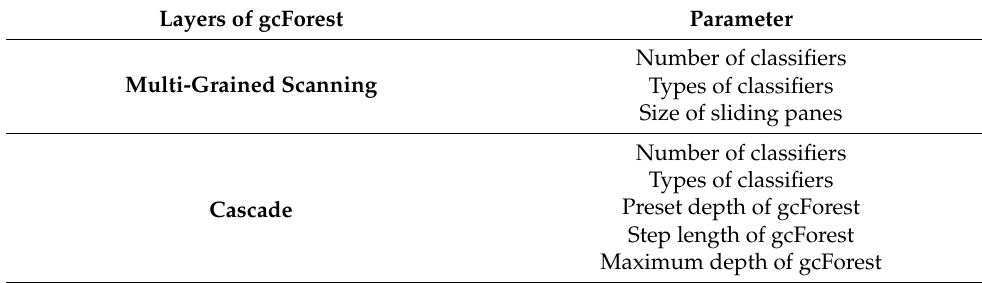
Table 7. Main parameters used in the